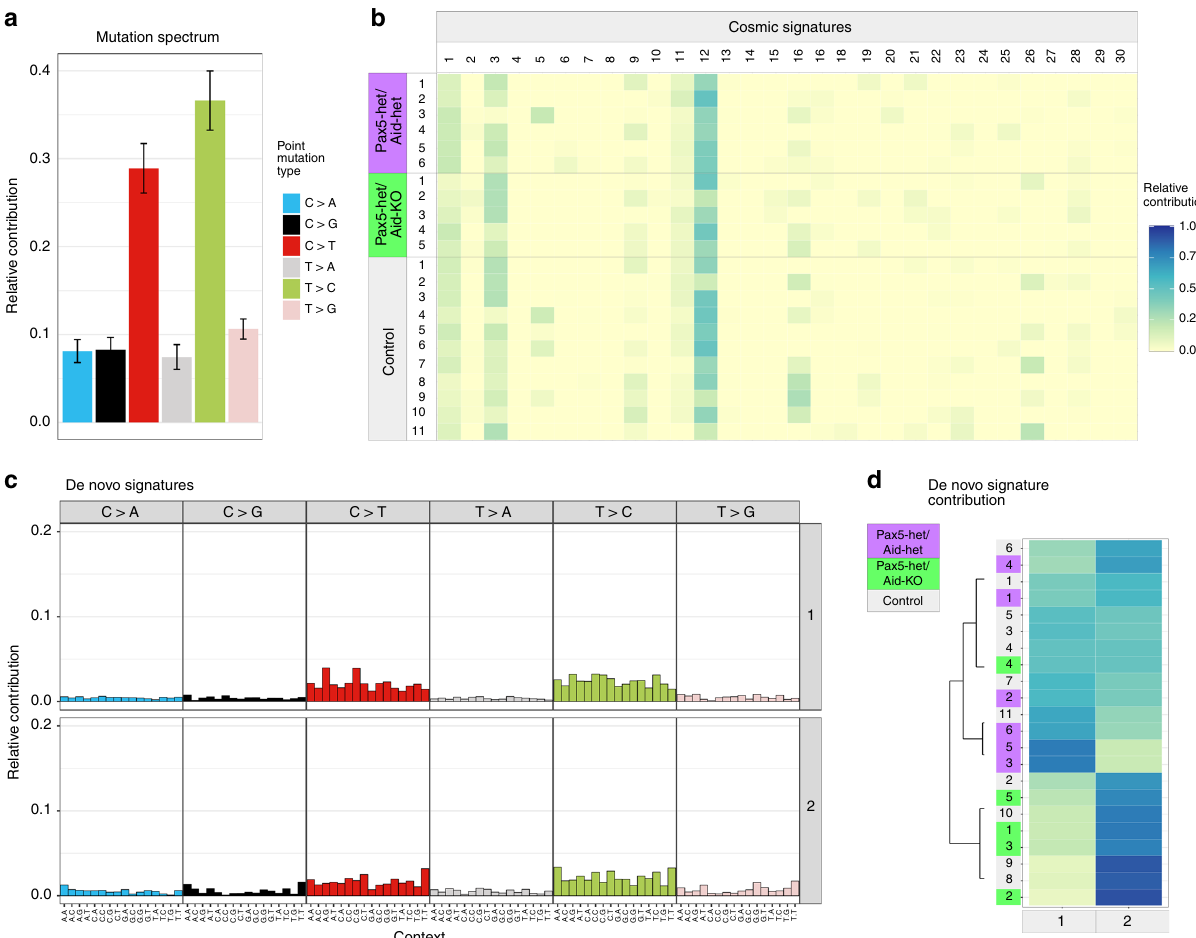
Fig. 3 Mutational patterns in Pax5-het/Aid-het and Pax5-het/Aid-KO B-ALL. a Mutation spectrum of total identi fi ed SNPs after fi ltering (median: